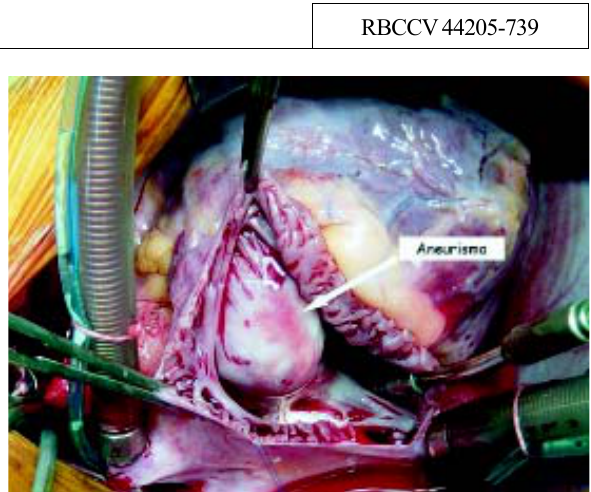
Fig. 1 – Abaulamento aneurismático do seio de Valsalva coronariano direito observado após a abertura do átrio direito.